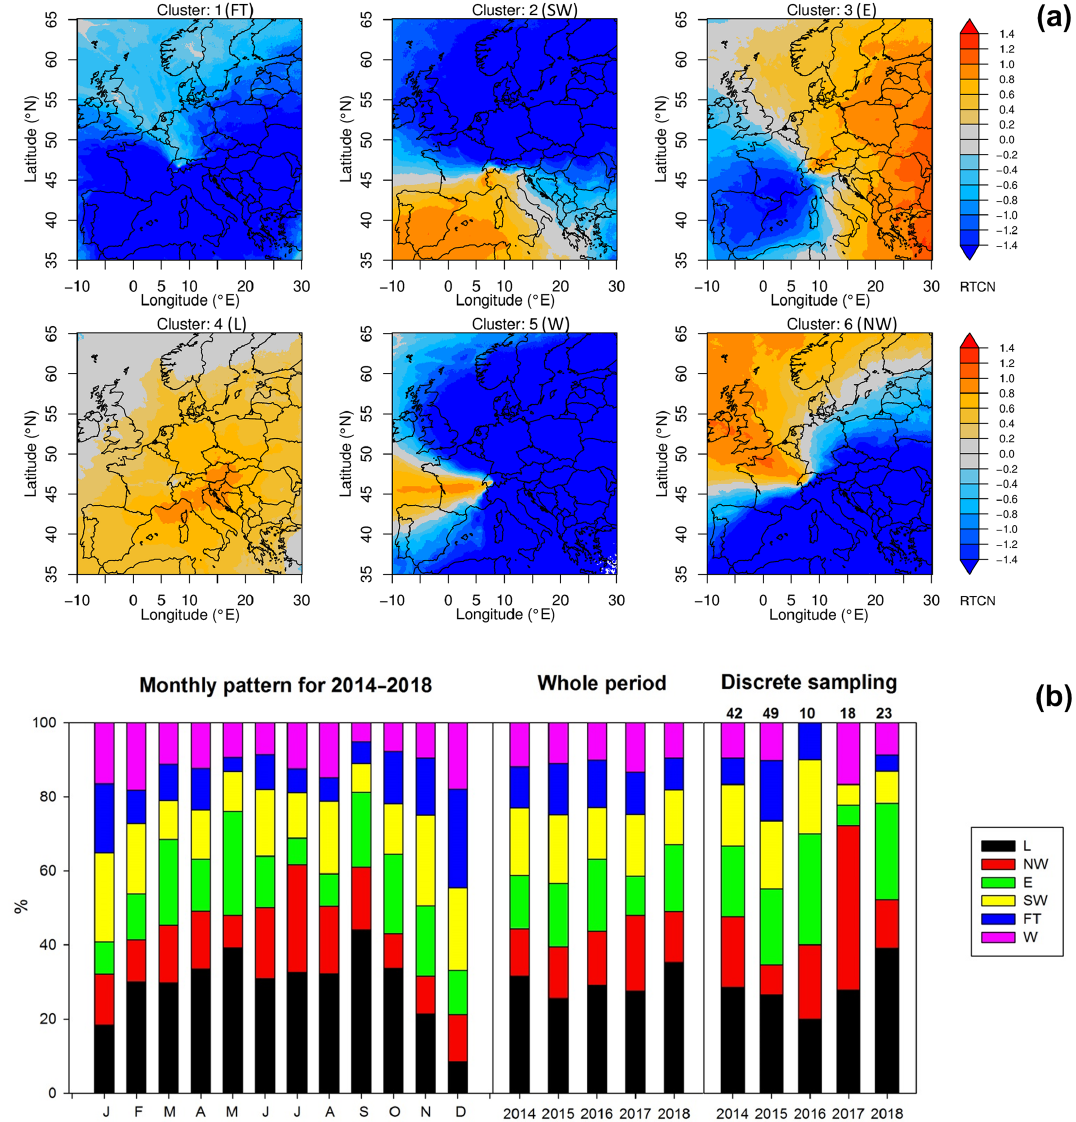
Figure 4. (a) Clusters of air mass transport regimes for Jungfraujoch shown as normalized surface source sensitivities over our sampling period. Cluster abbreviations refer to Free Troposphere (FT), Southwest (SW), East (E), Local (L), West (W) and Northwest (NW). The normalization was done by calculating the difference between cluster-average source sensitivity and whole-period-average source sensitivi- ties, divided by the period average. Orange colors indicate the main source regimes in each cluster, whereas blue colors indicate little to no influence on Jungfraujoch observations. The free tropospheric cluster showed lower than average surface sensitivity everywhere. (b) Cluster frequency of air mass transport regimes (%) shown as a monthly pattern (left) and interannual patterns for the whole periods (middle) and for the periods of discrete sampling (right). Numbers above the right figure indicate the total number of discrete samples per